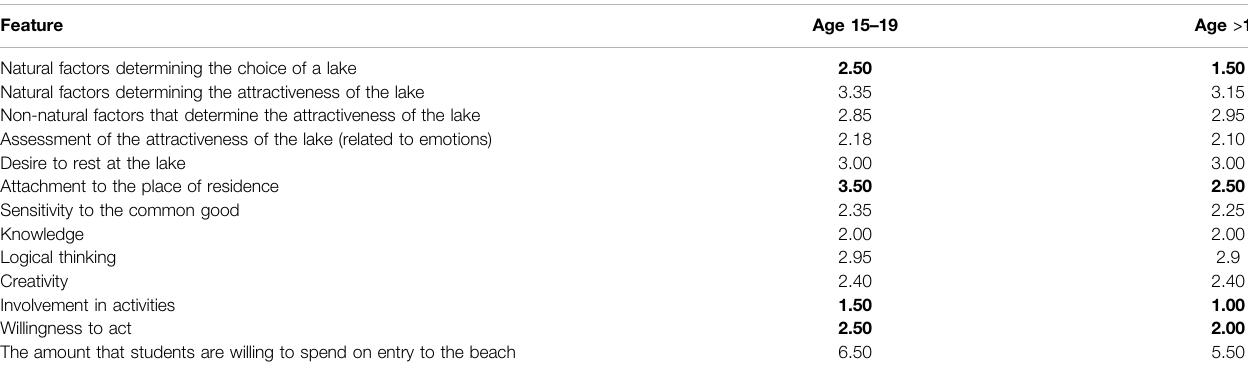
TABLE 3 | Summary of medians of individual variables in two analyzed age